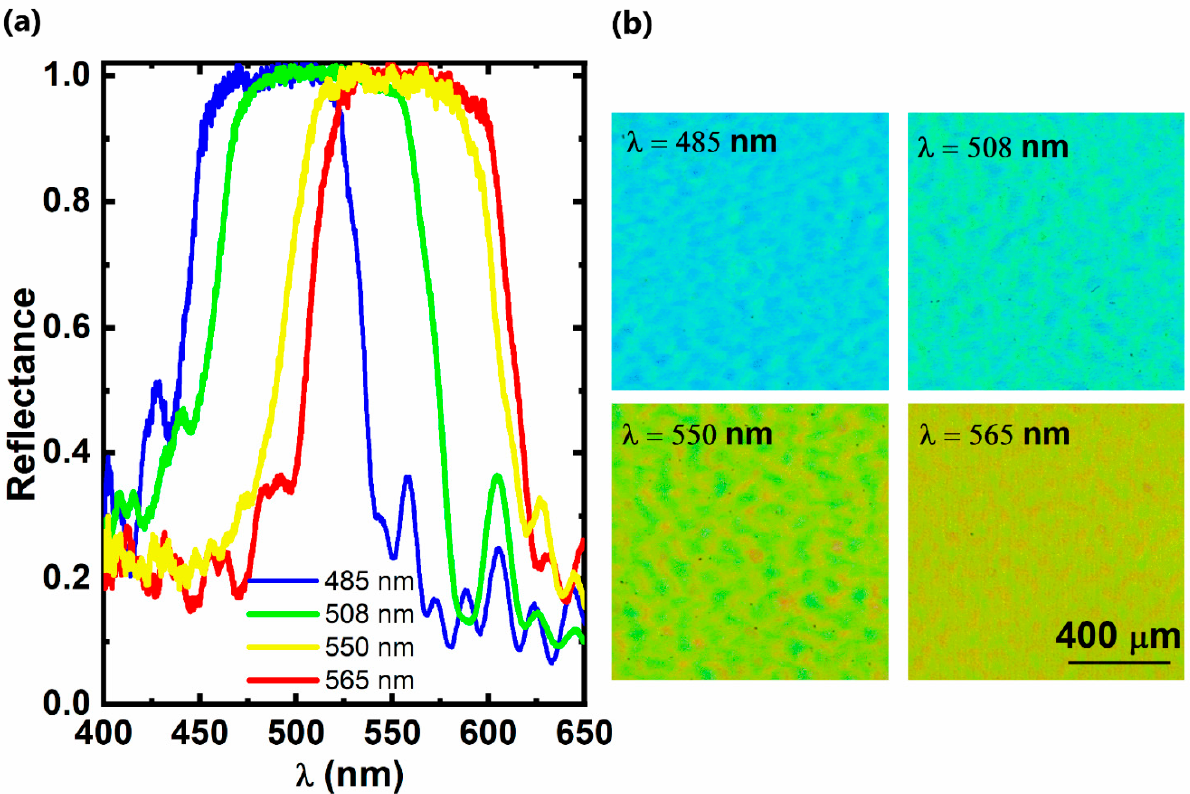
Figure 5. ( a ) Reflectance spectra from four different kinds of NP ‐ Al 0.01 Ga 0.99 N/GaN DBR structures, each with a central wavelength at 485 nm, 508 nm, 550 nm and 565 nm, respectively; ( b ) Optical images of these NP ‐ Al 0.01 Ga 0.99 N/GaN DBR structures taken using a white light source (scale bar = 400 μ m).